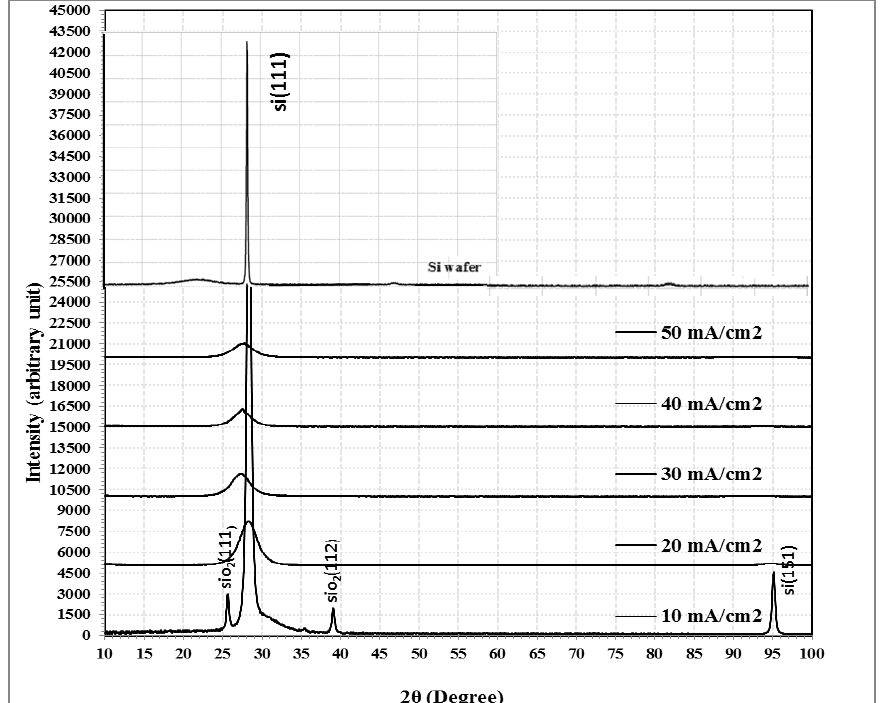
Fig. 3: X-ray diffraction patterns for PS with different etching current 10, 20, 30, 40 and 50 mA/cm 2